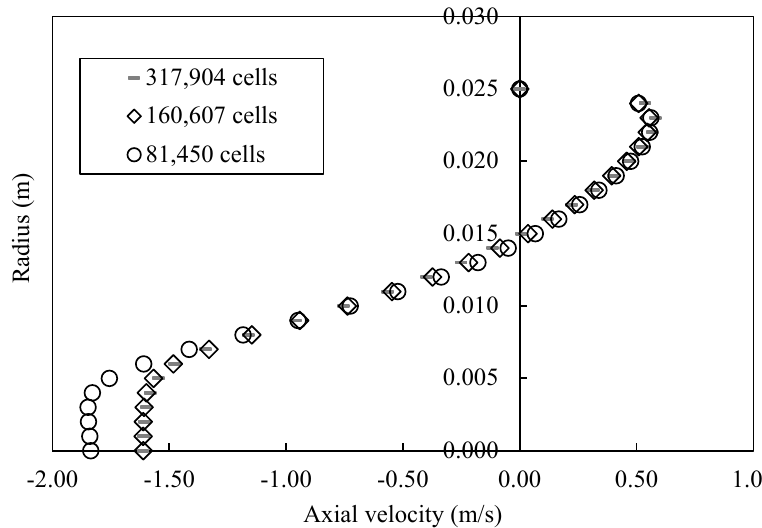
Figure 4. Radial velocity profile as a function of radius at x = 327 mm (centerline of the reactor) for 40 mm of oscillation amplitude and 2 Hz of oscillation frequency.